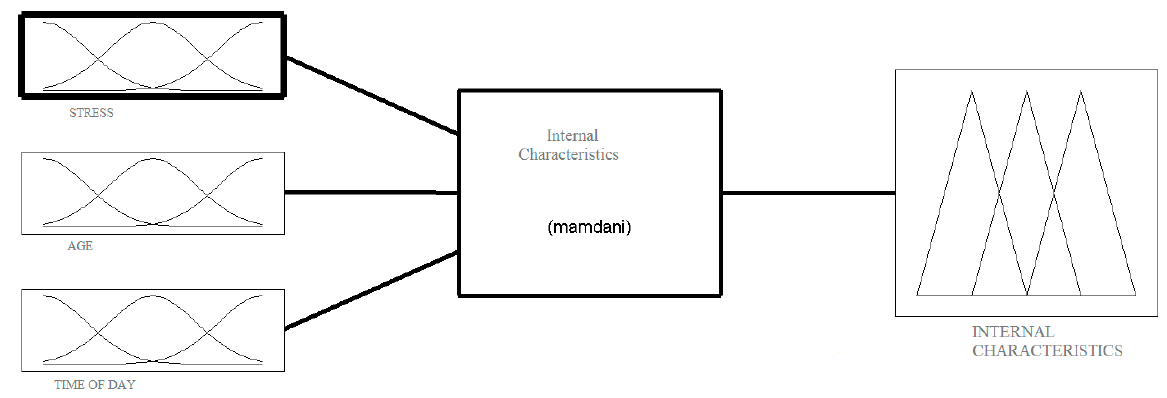
Figure 4. Mamdani model for internal characteristics simulation.